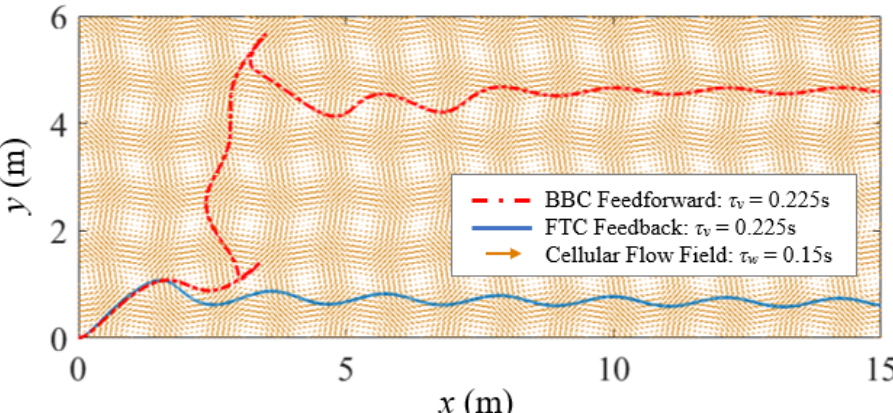
Figure 9. Case study 3: the trajectory comparison of the FTC-controlled and BBC-controlled vehicles with τ v = 0.225 s traversing a cellular flow with τ w = 0.15 s demonstrates that both vehicles achieve the control objective of reaching a desired horizontal position, x d = 15 m.